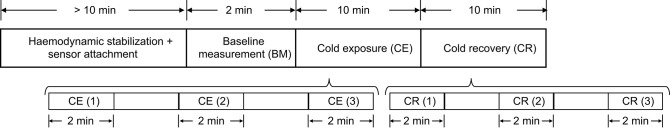
Measurement protocol for the whole-body cold exposure study.